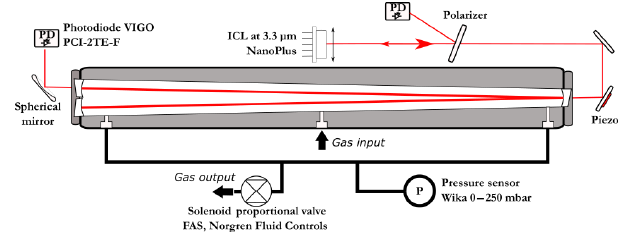
Figure 1. Details of the optical setup with the laser injection and phase control (piezo mounted on the injection steering mirror as- sembly). The polarizer is tilted and its reflection used for acquiring the laser power spectrum before the cavity injection. At the cavity output, a spherical mirror is used to focus the light on the second (signal output)